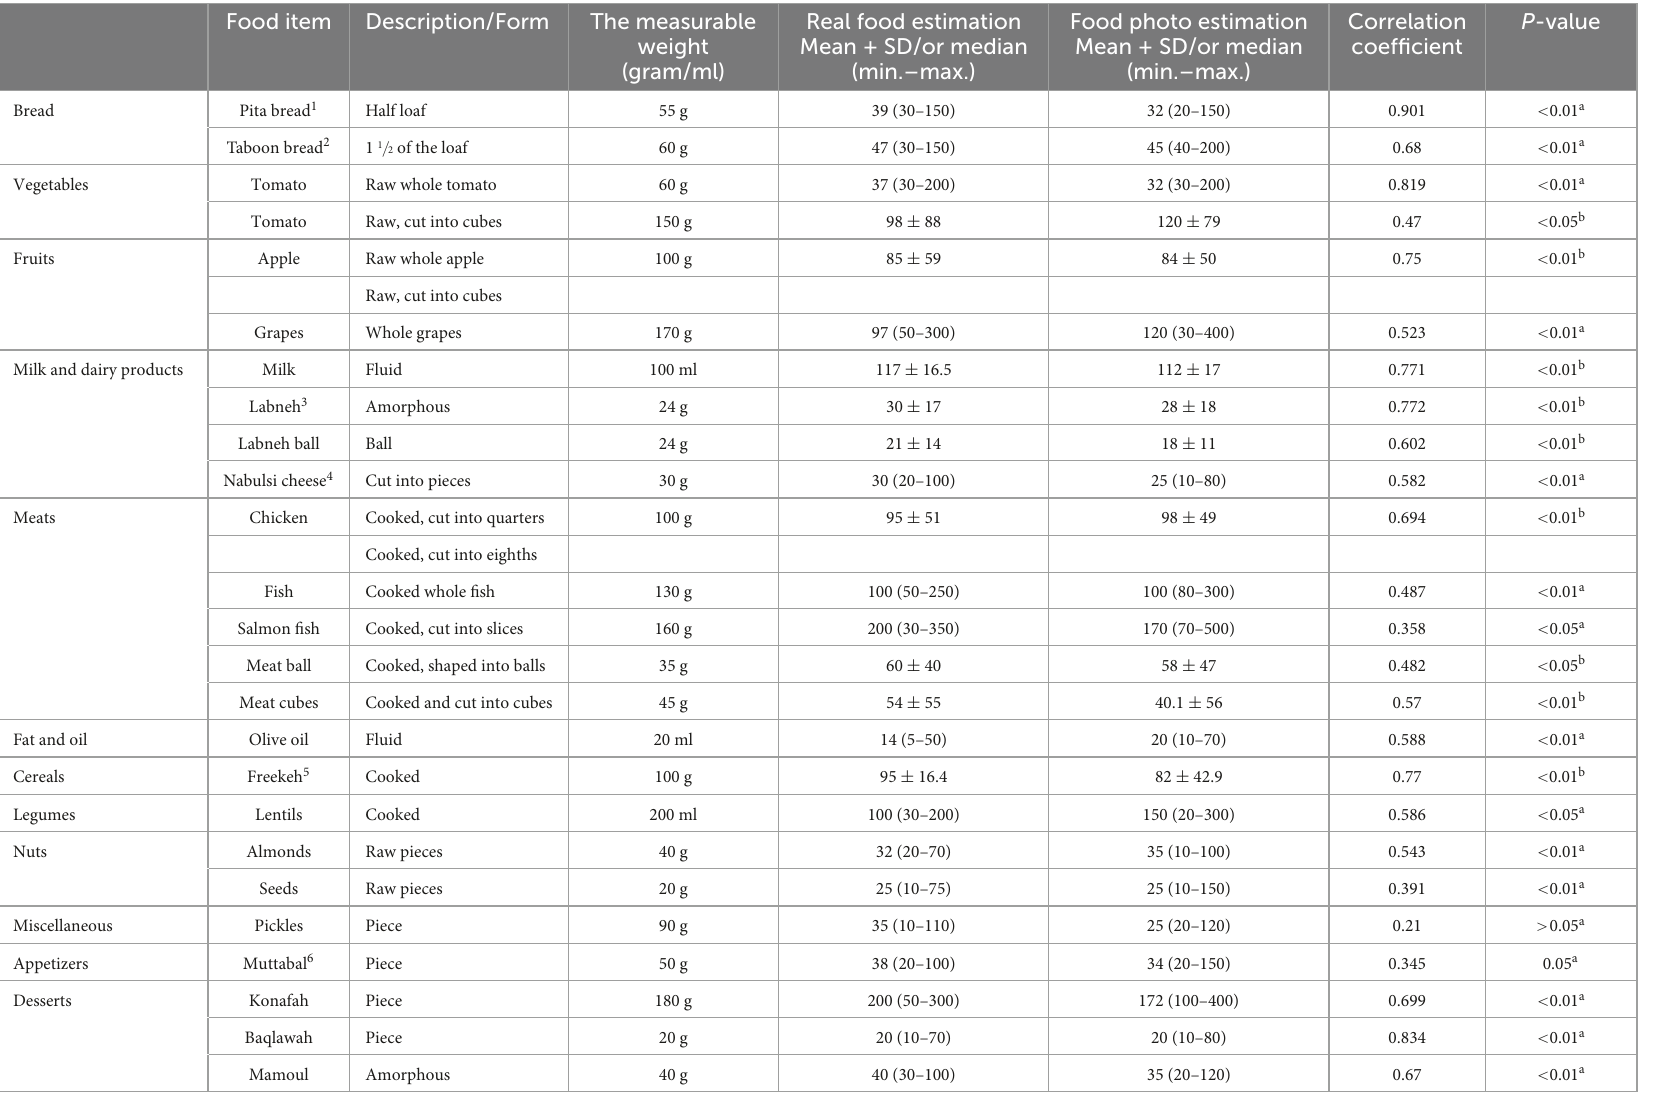
TABLE 2 The correlations between the estimated portion values for real food and food photo using weight and